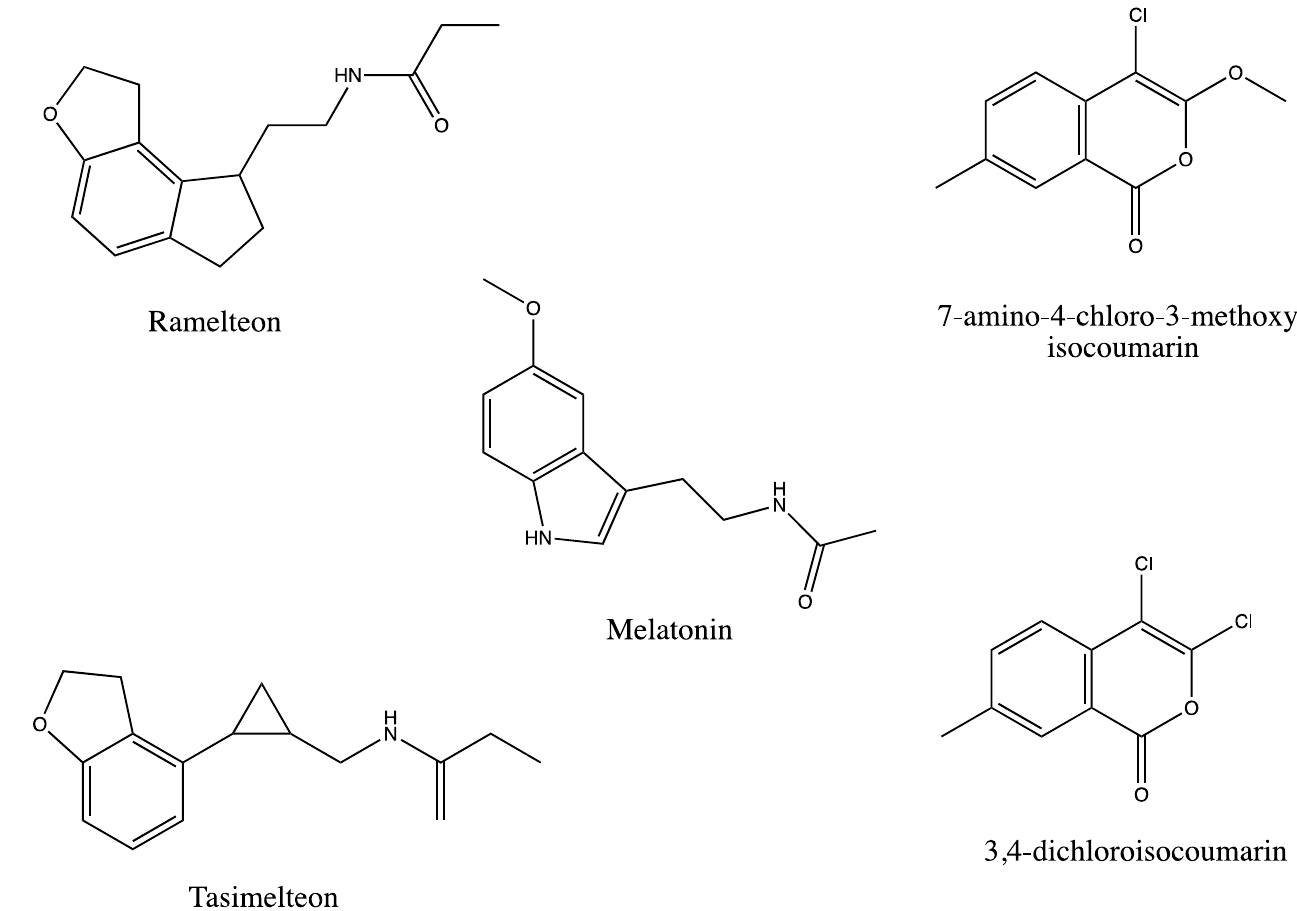
Figure 6. Structures of melatonin, mammalian receptor agonists ramelteon and tasimelteon, and rhomboid protein inhibitors 7-amino-4-chloro-3-methoxy-isocoumarin and 3,-dichloroisocoumarin.